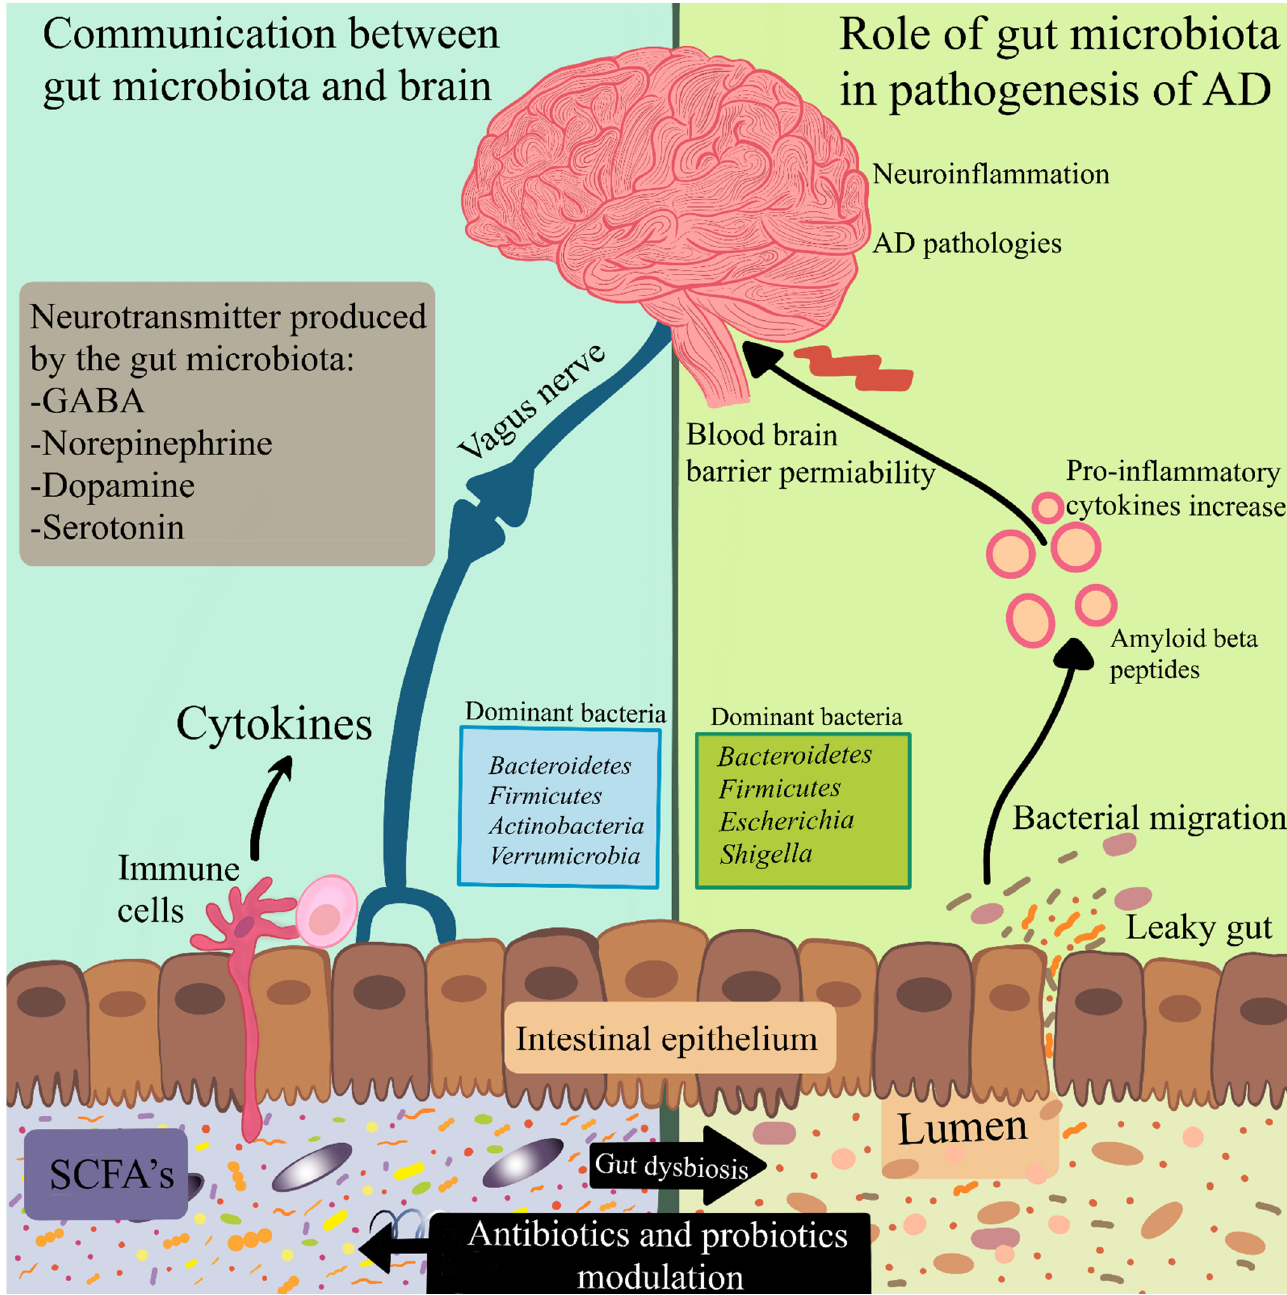
Figure 2. Modulation of the microbiota–gut–brain axis by antibiotics and probiotics. The communication between the gut microbiota and the brain includes neuronal, immune-mediated, and metabolite-mediated pathways. Gut dysbiosis leads to activation of the immune response and alters the production of neurotransmitters as well as bacterial metabolites. These may have a contribution to abnormal signaling through the vagus nerve. Reduction in the integrity of the gastrointestinal barrier causes bacterial migration and inflammation. Pro-inflammatory cytokines induce disruption of the blood–brain barrier permeability. Antibiotics can hinder the growth of certain bacteria, and probiotics have the potential to normalize the gut microbiota in microbiota–gut–brain